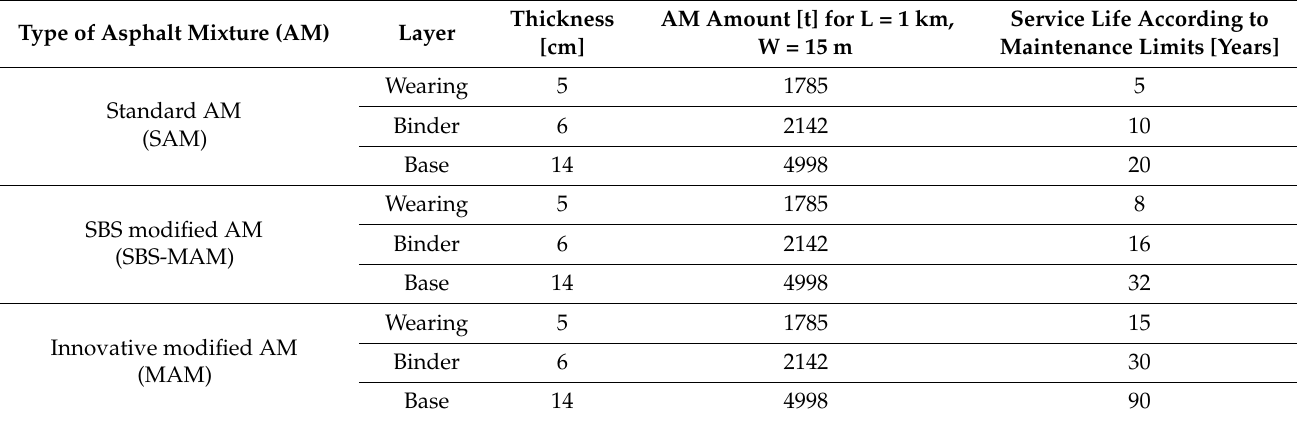
Table 2. First case study. Characteristics and performance of different asphalt pavements with same thickness and different service life for each layer determined by pavement layers technical performance (AM stiffness and durability).